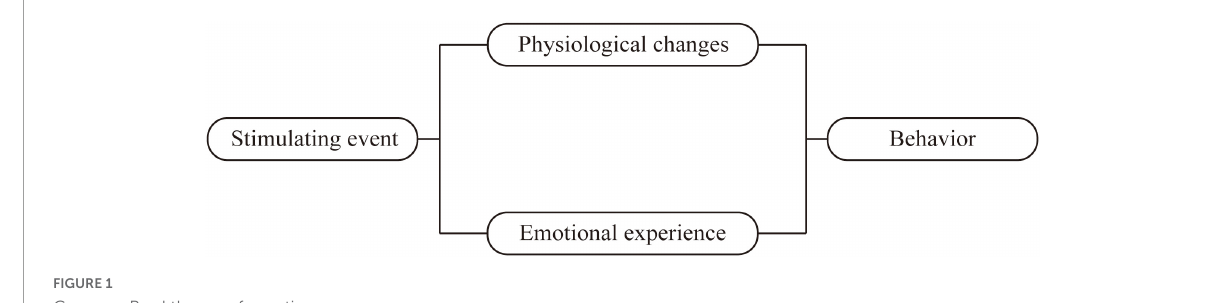
FIGURE1 Cannon–Bard theory of emotion.